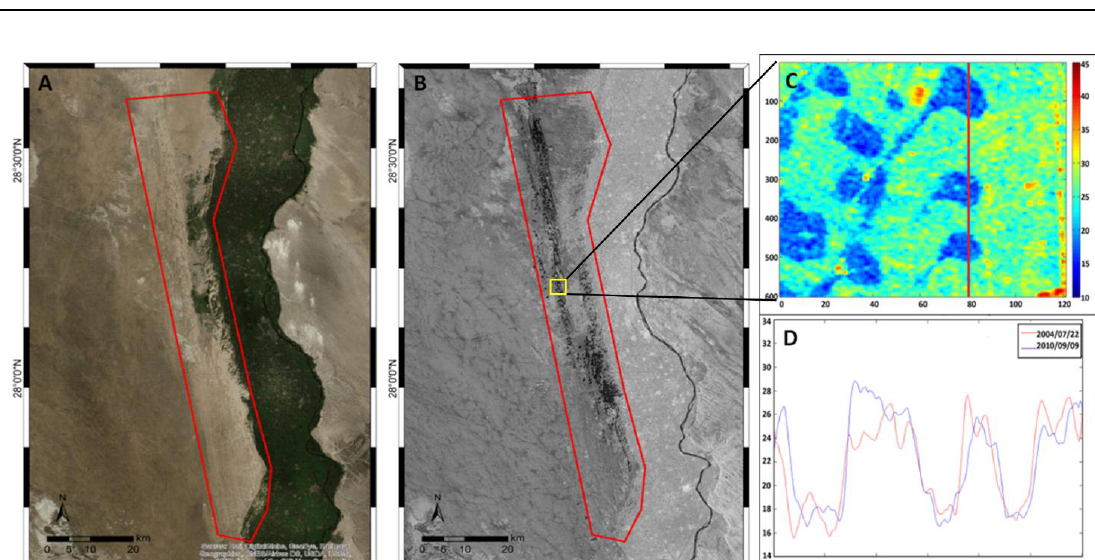
Figure 4. Optical ( A ) and SAR ( B ) view over the South Rayan dune field, delimited by the red polygon. Barchan dunes are the dark areas within the red line in ( B ). ( C ) shows the intensity of the SAR backscatter signal in decibels over the yellow rectangle in B in radar coordinates. ( D ) shows the profile of the vertical red line in Figure ( C ) for two different SAR data acquired on 2004/07/07 and 2010/09/09 depicting a very low intensity of signal over the barchan dunes.